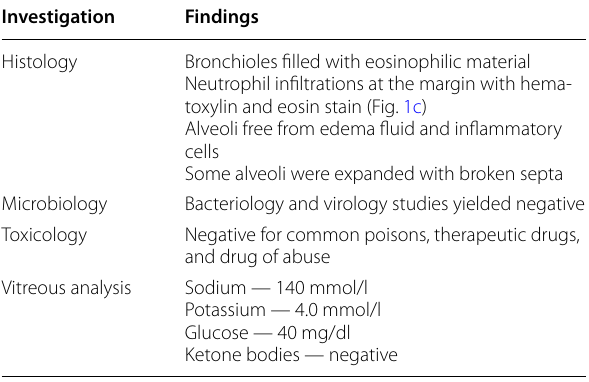
Table 2 Summary of lab investigations Investigation Findings